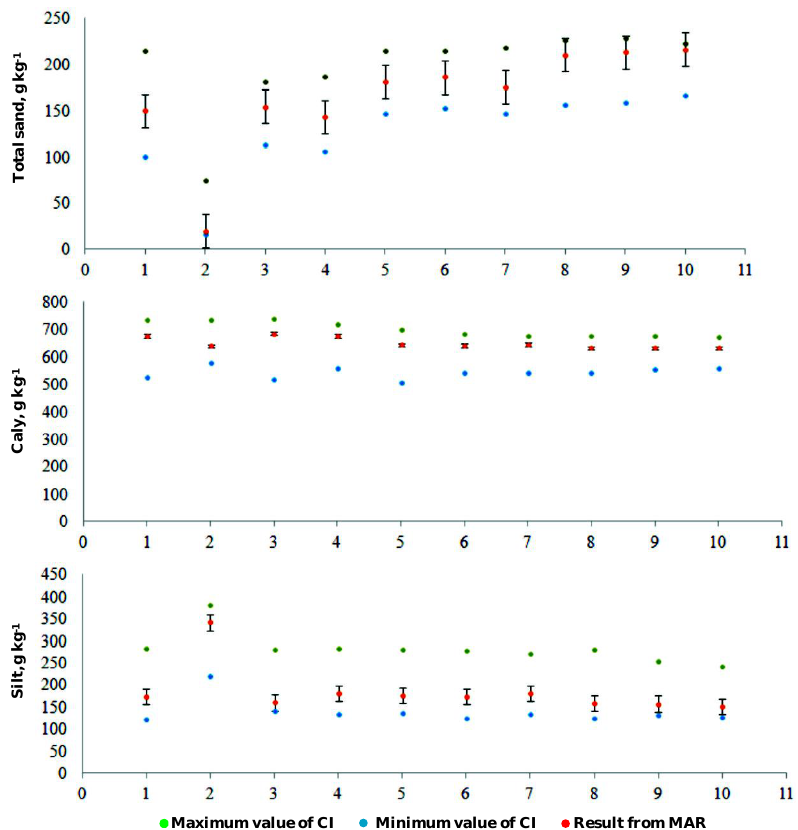
Figure 5. Accuracy analysis for 11 soil samples of the Heavy clay soil textural class: representation of the minimum and maximum values of the confidence intervals (CI), means and average standard errors (bars) for total sand, silt and clay contents as determined by particle-size analysis using the reciprocal shaker (RSh).